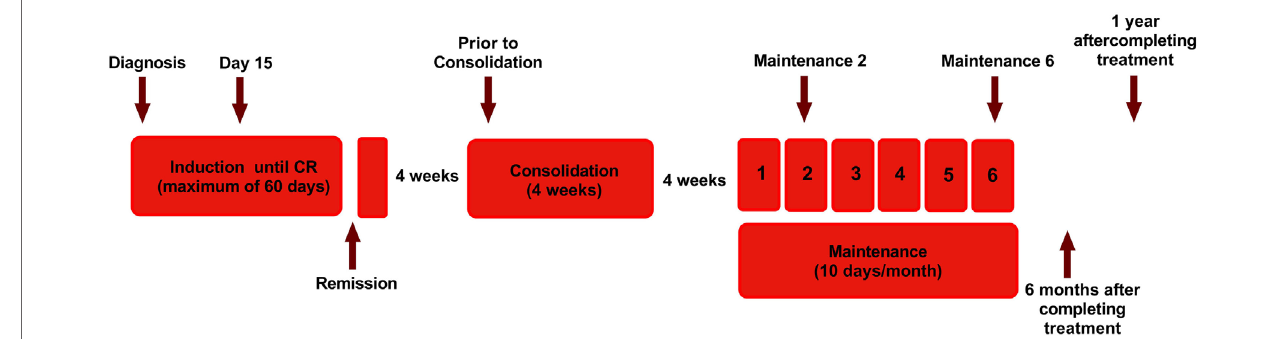
FigUre 1 | Diagram showing the treatment protocol followed in our institution for newly diagnosed acute promyelocytic leukemia and time points of sample collection for this study. Arsenic trioxide (ATO) was administered intravenously at a dose of 10 mg for adults and 0.15 mg/kg for pediatric patients. Single-agent ATO was administered until complete hematologic remission (CR) for a maximum of 60 days. Following a 4-week interval, ATO was administered for another 4 weeks as a consolidation course, for those in CR. Again after a 4-week interval, for those continuing to remain in CR, single agent ATO was administered 10 days a month for 6 months (31). The arrow marks represent the time points in which samples were